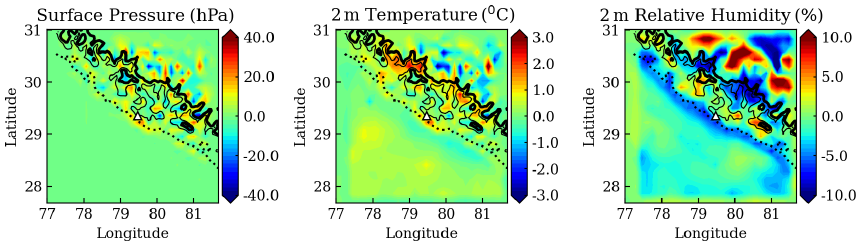
Figure 10. The effect of the two-way nesting on d01 is shown. The difference between the simulations with feedback (WRF-F) and without feedback (WRF-WF) is shown for surface pressure, 2m temperature, and 2m relative humidity along with three elevation contours at 500m (dashed), 1500m (thin solid), and 2000m (thick